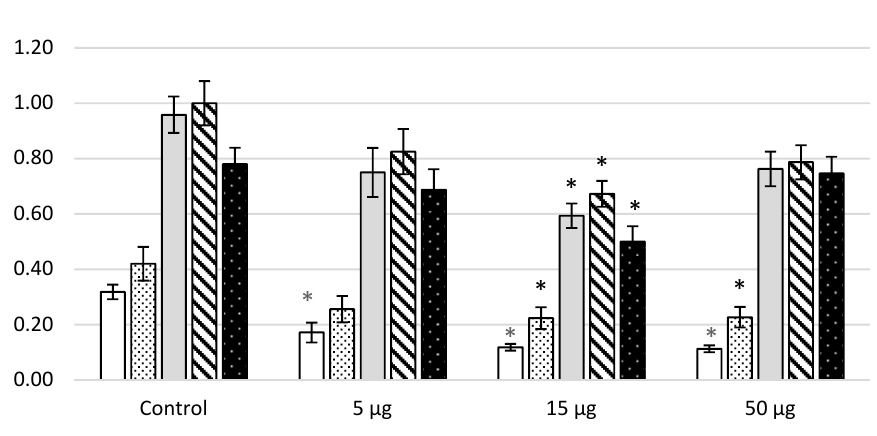
Figure 2. The thresholds (mA, M ± m) of the painful and affective reactions of rats in the tail electric stimulation test after intracerebroventricular L-lysine administration. Note: the obtained data were analyzed by ANOVA and the post hoc Dunnett’s test; * – p < 0.05–0.001 in comparison with the control values.